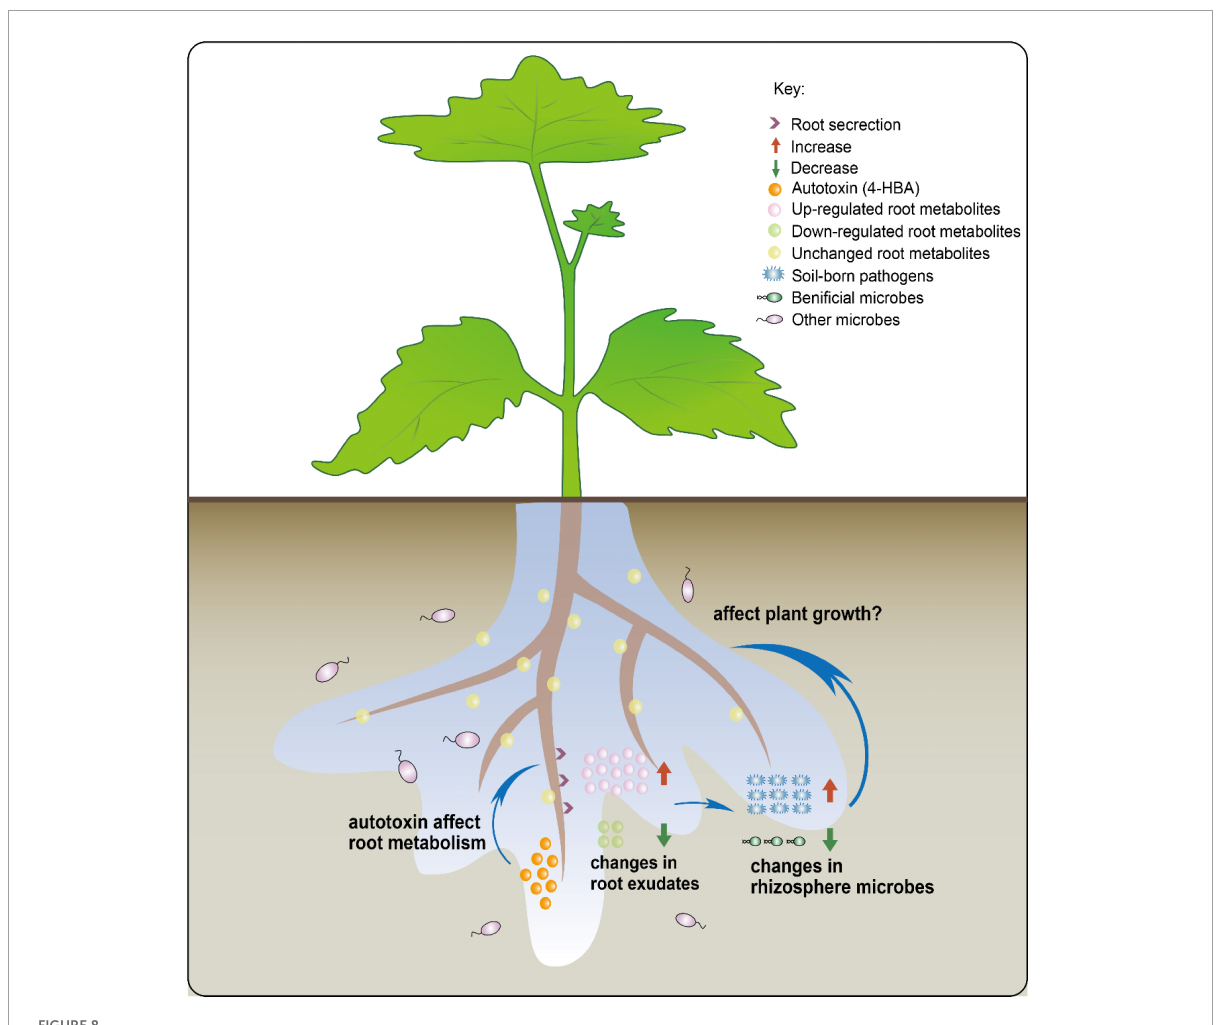
FIGURE8 The overview of the mechanism by which autotoxin affects root exudates to change rhizosphere